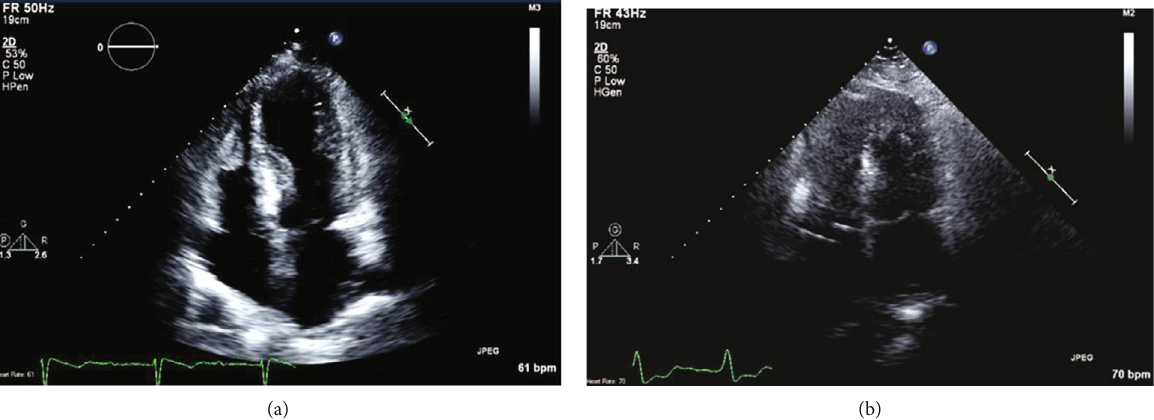
Figure 6: Apical 4 chamber ECHO view (a) on presentation suggestive of takotsubo cardiomyopathy followed by repeat apical 4 chamber view (b) two months later showing recovery of previously noted wall motion